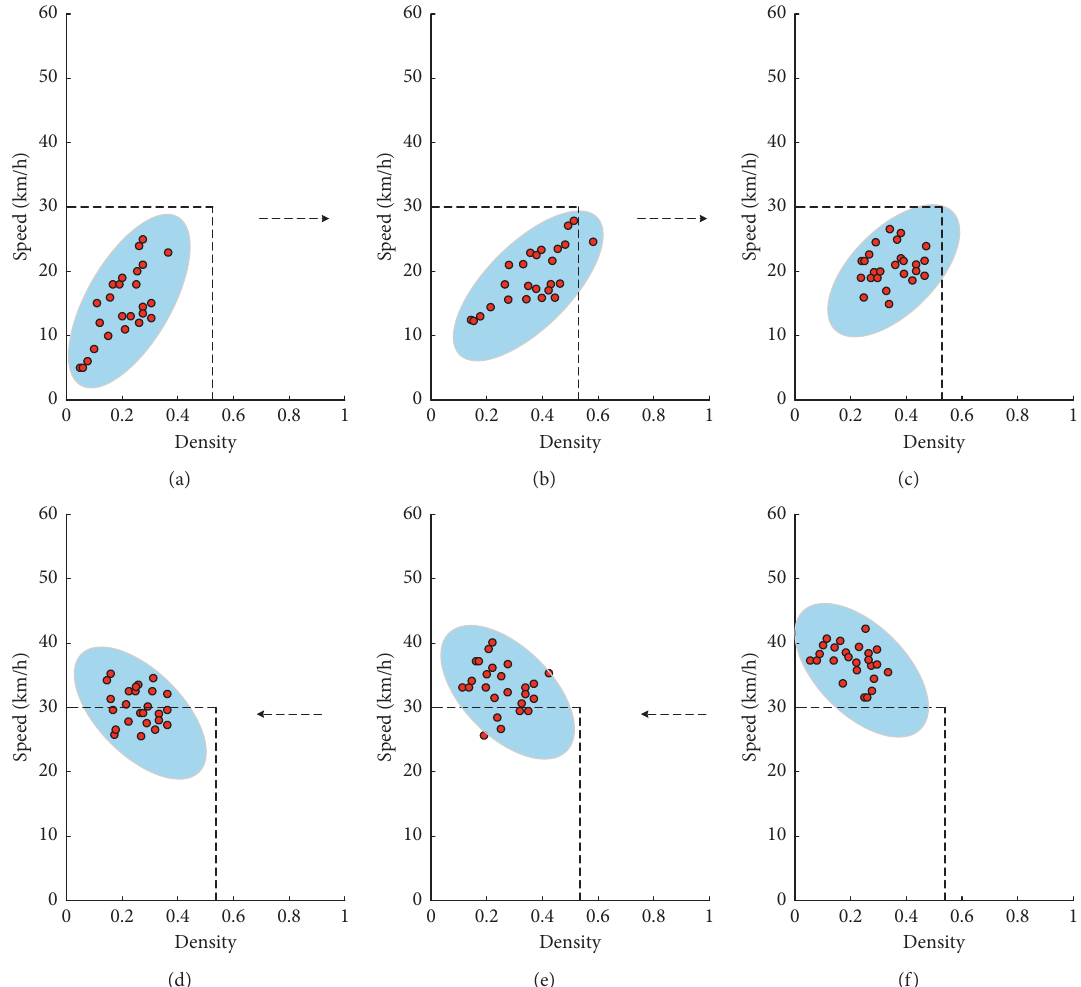
Figure 9: Effective detection of regional traffic flow: the fundamental diagram before and after the frequent overflow control has been applied.